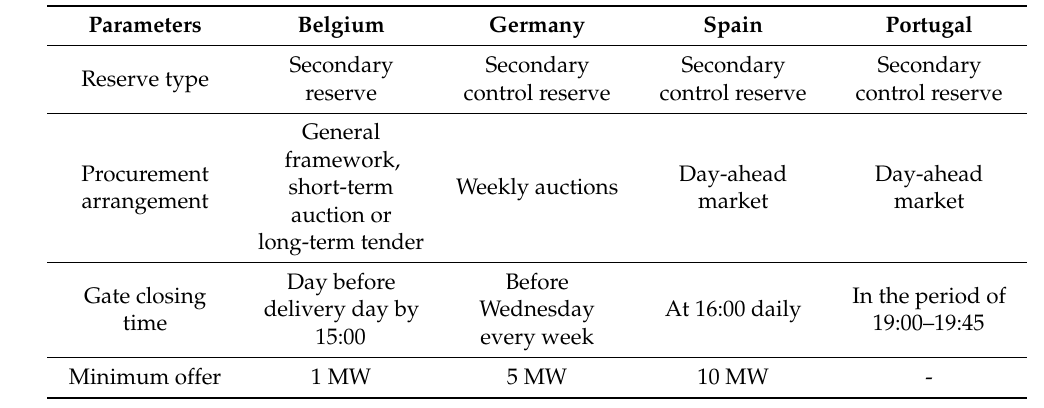
Table 4. Summary of FRR-A services unified under the ENTSO-E classification, including Belgium,